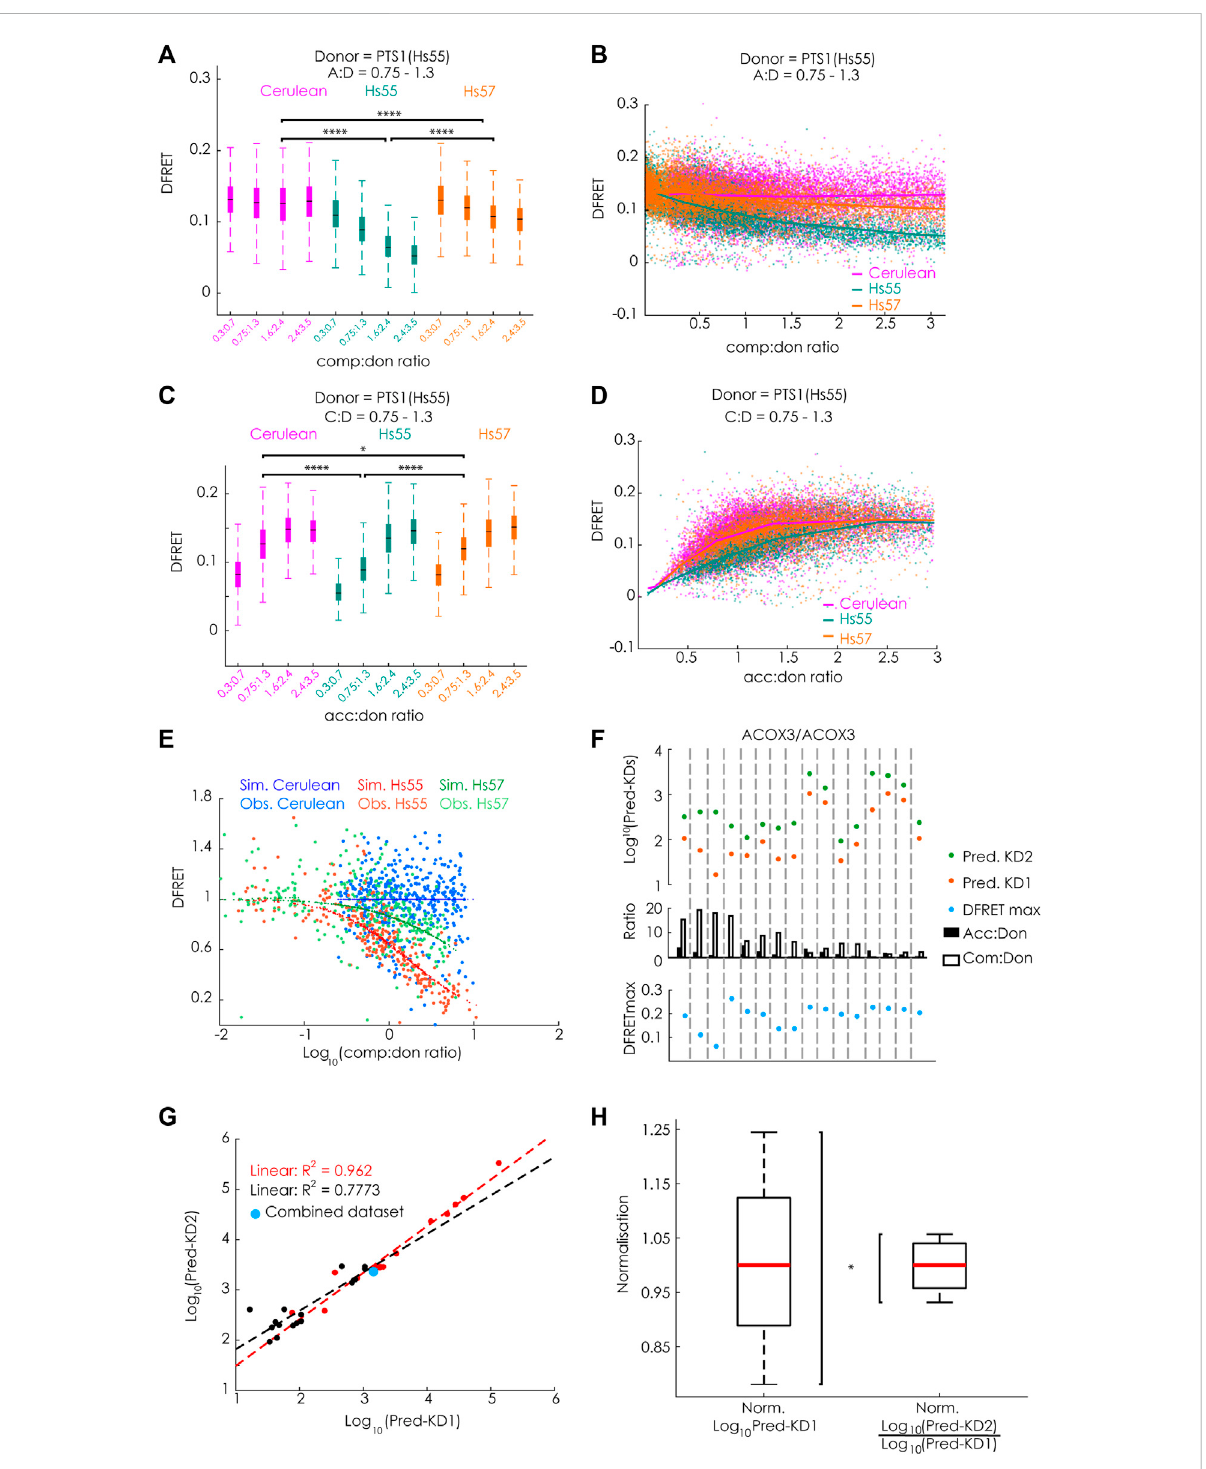
FIGURE 3 FlowFRET allows acompetition assayinlivingcells: pex5 − / − MEFexpressing mCherry-PEX5(TPR)as acceptor andvariousdonorandcompetitor molecules were analyzed by fl ow cytometry to measure a large number of cells; (A – E) donor: EGFP-PTS1(Hs55), competitor: Cerulean, Cerulean- PTS1(Hs55)orCerulean-PTS1(Hs57); (A) comparisonofDFRETvaluesofsubpopulationsofcellssharinganacc:donratioof0,75 < x < 1,3anddifferent comp:don ratios, (B) DFRET decay curves (increasing comp:don) of all cells sharing an acc:don ratio of 0,75 < x < 1,3; (C) comparison of DFRET valuesofsubpopulations ofcellssharingancomp:don ratioof0,75 < x < 1,3anddifferentacc:donratios; (D) plottingDFRETvalues ofallcellssharing